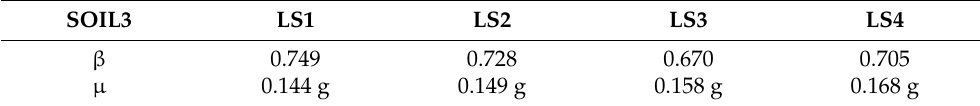
Table 7. Lognormal standard deviation ( β ) and median ( µ ) values of SOIL3 at limit states (LSi). SOIL3